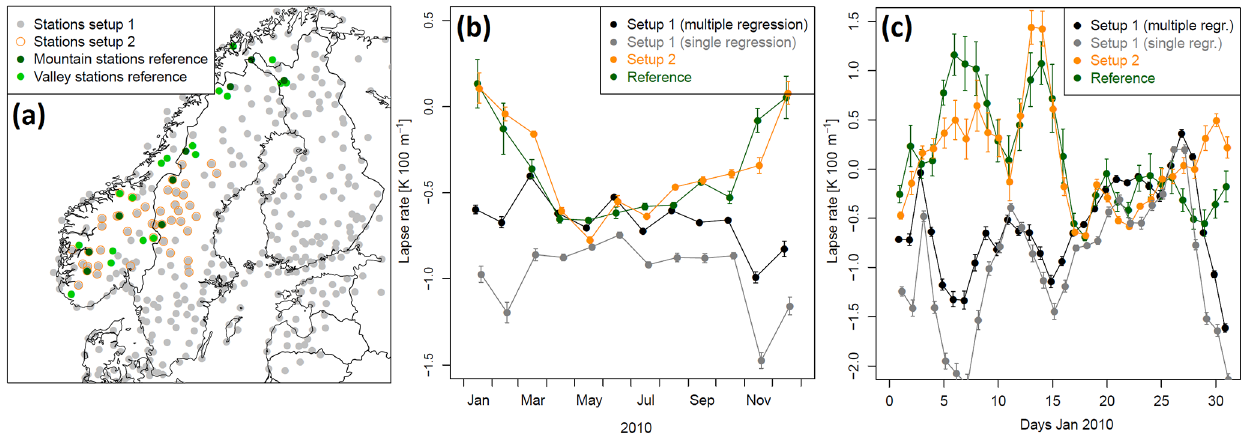
Figure 7. Comparison of regression setups used to estimate temperature lapse rates for mean temperature in Scandinavia. (a) Stations used in different setups; (b) monthly lapse rates in 2010; (c) daily lapse rates for January 2010.